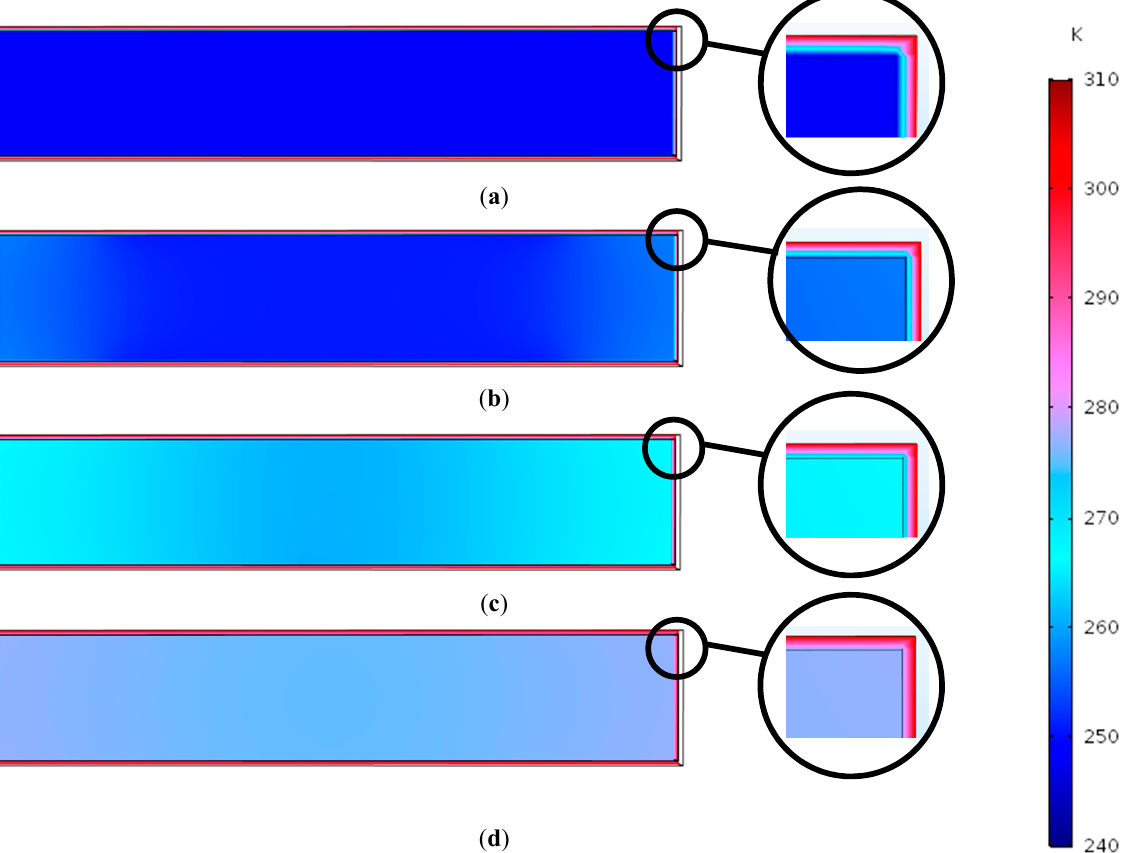
Figure 11. The model of a full-scale refrigerated semi-trailer with marked measurement points for plotting the graphs of internal temperature.